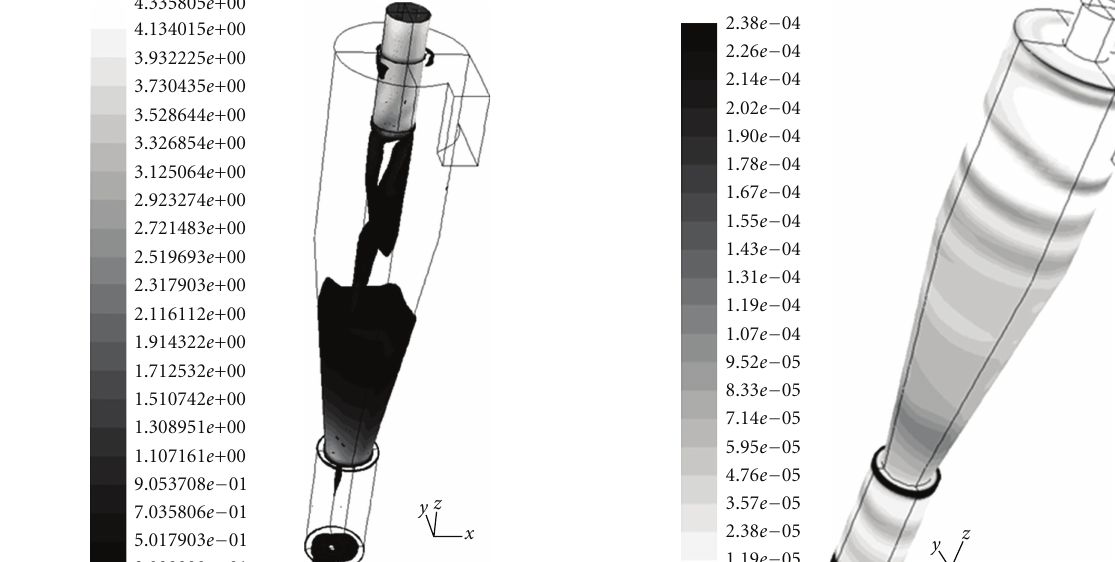
Figure 8: Particles volume fraction at y = 0 (0.01kg/m 3